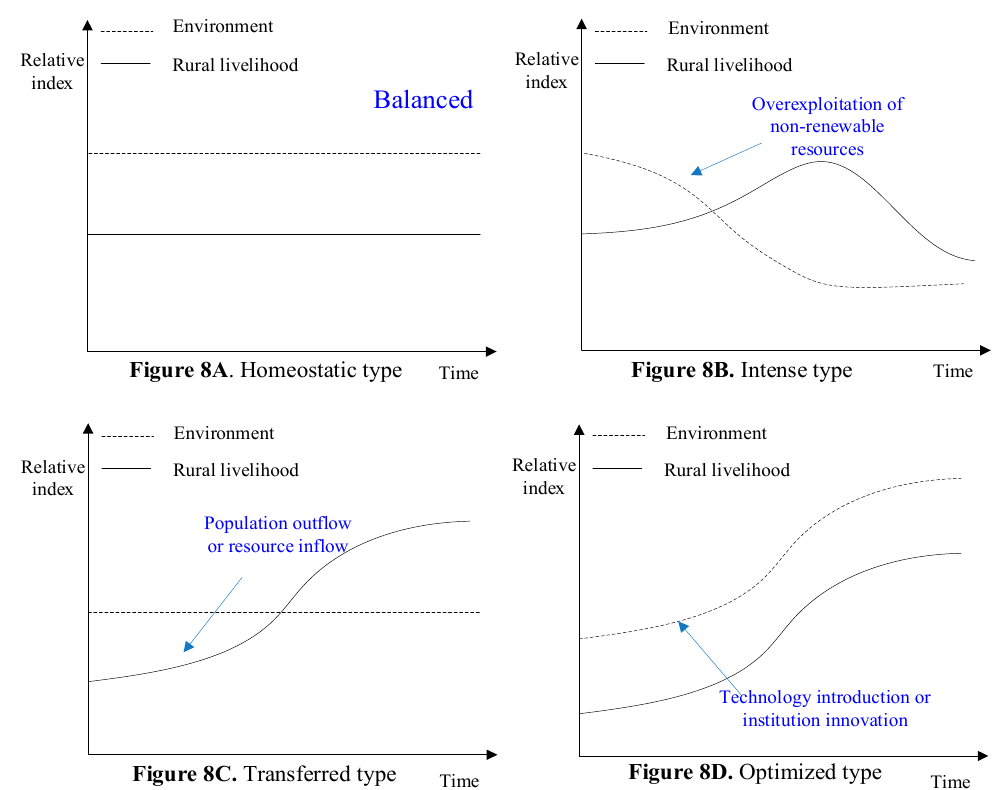
Figure 8C. Transferred type Figure 8D. Optimized type Figure 8. Coupling relationship between rural livelihoods and the Figure 8A–D. Coupling relationship between rural livelihoods and the environment.